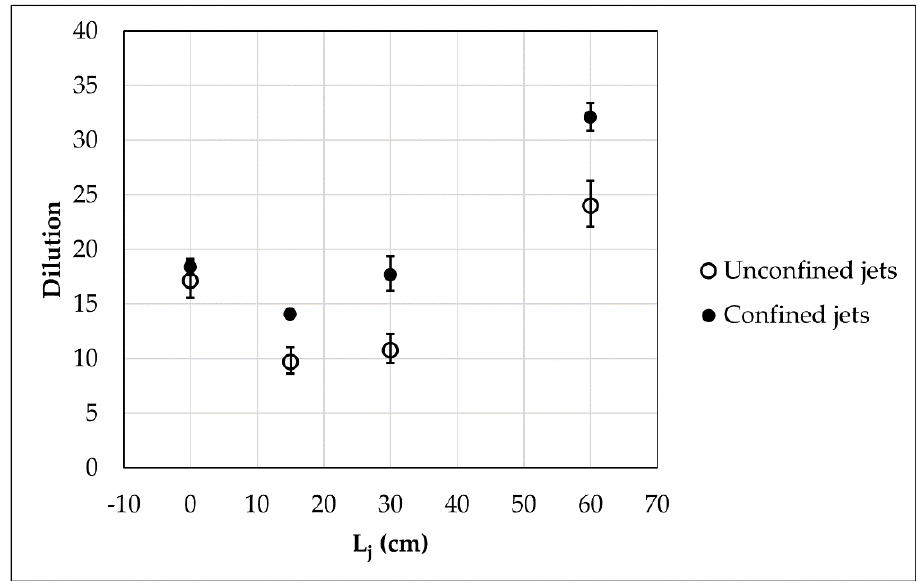
Figure 6. Comparison of dilution of confined jets with H c = 10 cm and unconfined jets. ( ∆ s = 10 psu for both unconfined and confined jets, D c = 4.4 cm for the confined jets.).